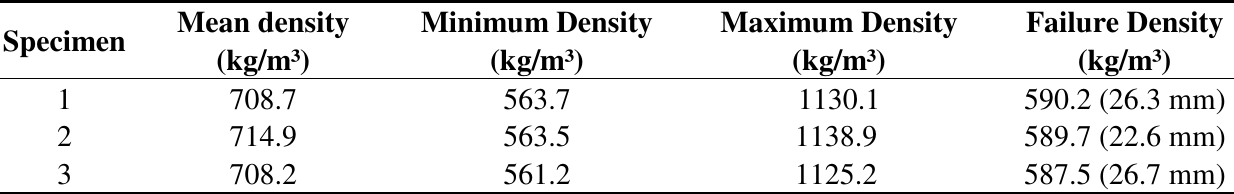
Table 1. Density values and failure position related density of tested medium density fiberboard (MDF)